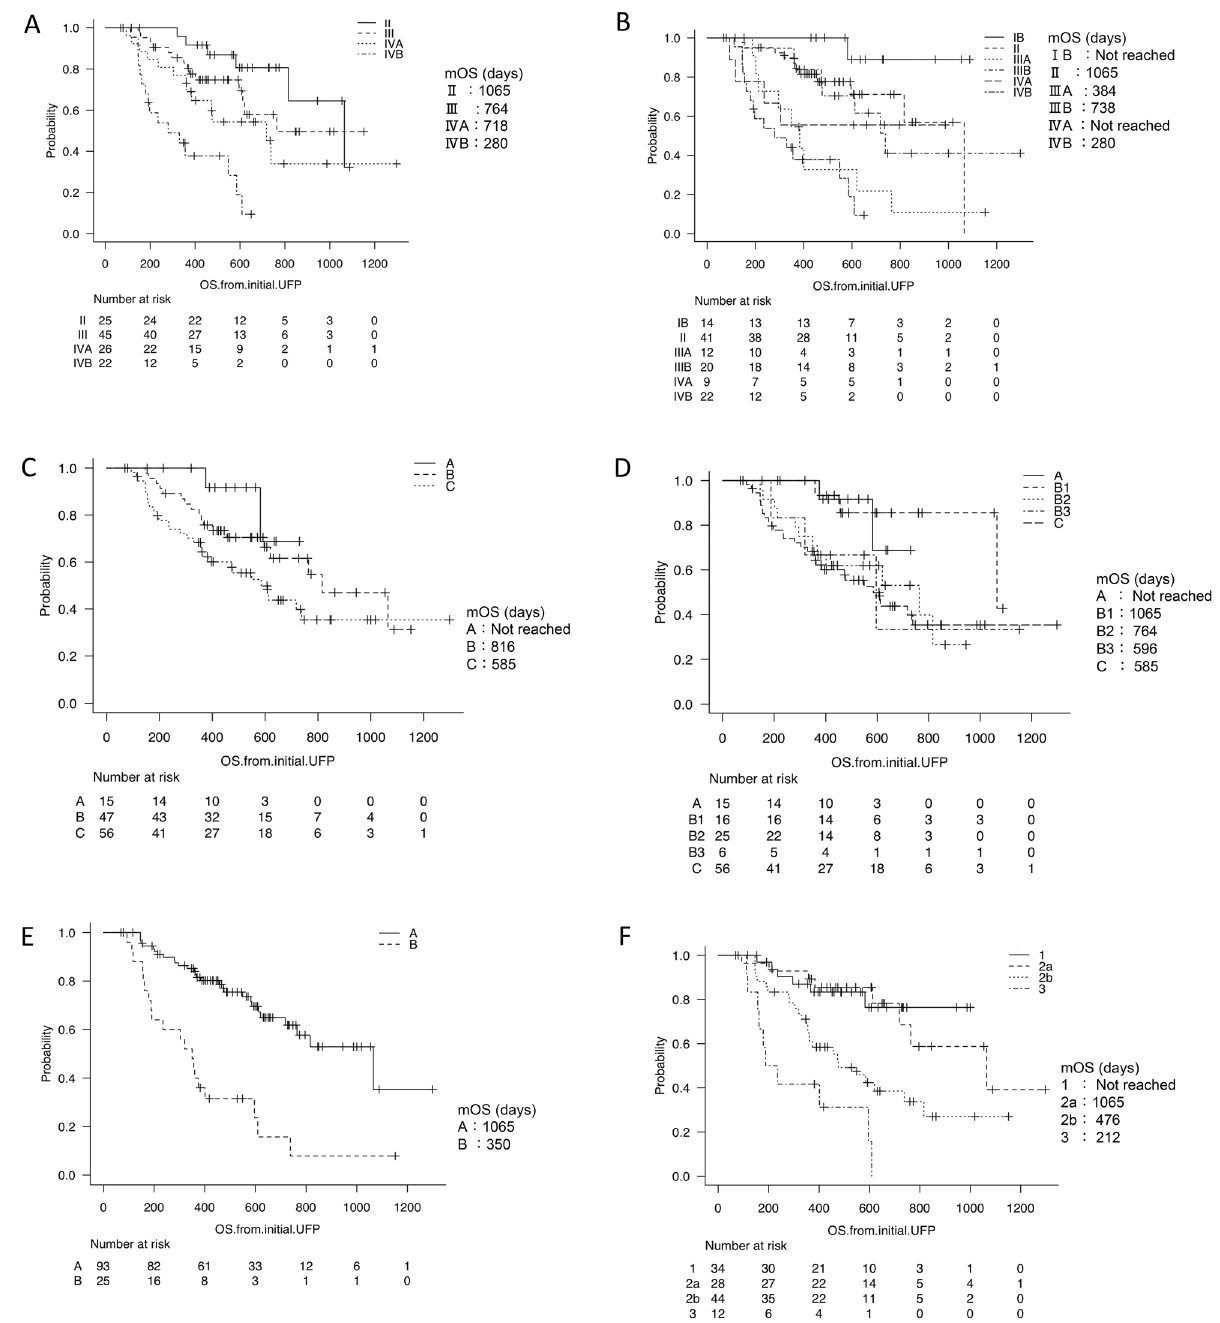
Figure 2. Survival time depending on the various kinds of tumor staging systems and the liver functional reserve. The survival curves of the tumor staging systems based on the general rules for the clinical and pathological study of primary liver cancer ( A ), Union for International Cancer Control (UICC) ( B ), Barcelona Clinic Liver Cancer (BCLC) ( C ) and Barcelona Clinic Liver Cancer (BCLC) with Kinki criteria ( D ) are shown. mOS stage based on the general rules for the clinical and pathological study of primary liver cancer, I/II/III/ IVA/IVB, was NA/1065/764/718/280 days, respectively ( A ). mOS of UICC staging, IB/II/IIIA/IIIB/IVA/IVB, was Not reached/1065/384/738/Not reached/280 days, respectively ( B ). mOS of BCLC stage, A/B/C, was Not reached/816/585 days, respectively ( C ). mOS of a sub-classification of BCLC (Kinki criteria) stage, A/B1/B2/ B3/C, was Not reached/1065/764/596/585 days, respectively ( D ). The survival curves of liver functional reserve based on Child–Pugh ( E ) and ALBI grade ( F ) systems are shown. mOS of HCC patients with Child–Pugh A/B/C was 1065/350 days, respectively ( E ). Moreover, the mOS of HCC patients with albumin-bilirubin (ALBI) grade 1/2a/2b/3 was Not reached/1065/476/212 days ( F